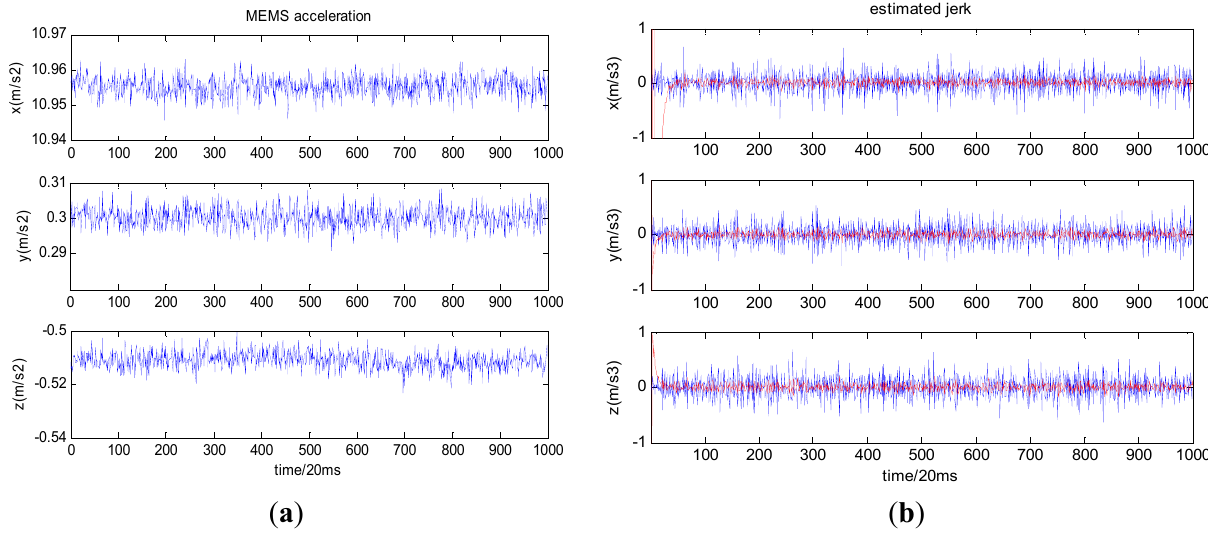
Figure 2. Jerk estimated from the MEMS acceleration with the two methods ( a ) MEMS acceleration; ( b ) Jerk estimated with the two methods.